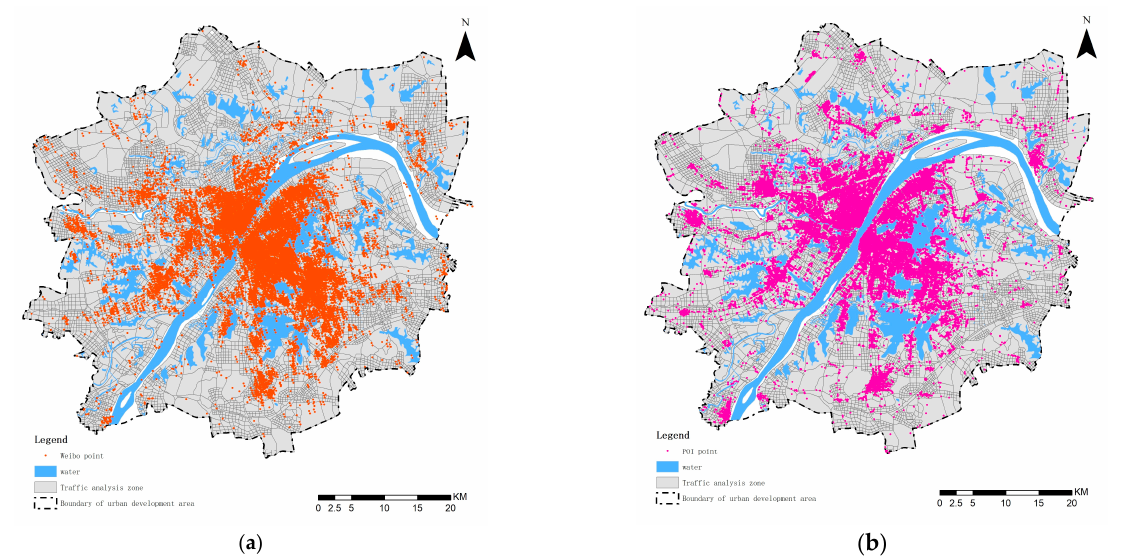
Figure 3. Visualization results of Weibo and POI points: ( a ) Weibo sign-in data distribution display; ( b ) POI data distribution display.